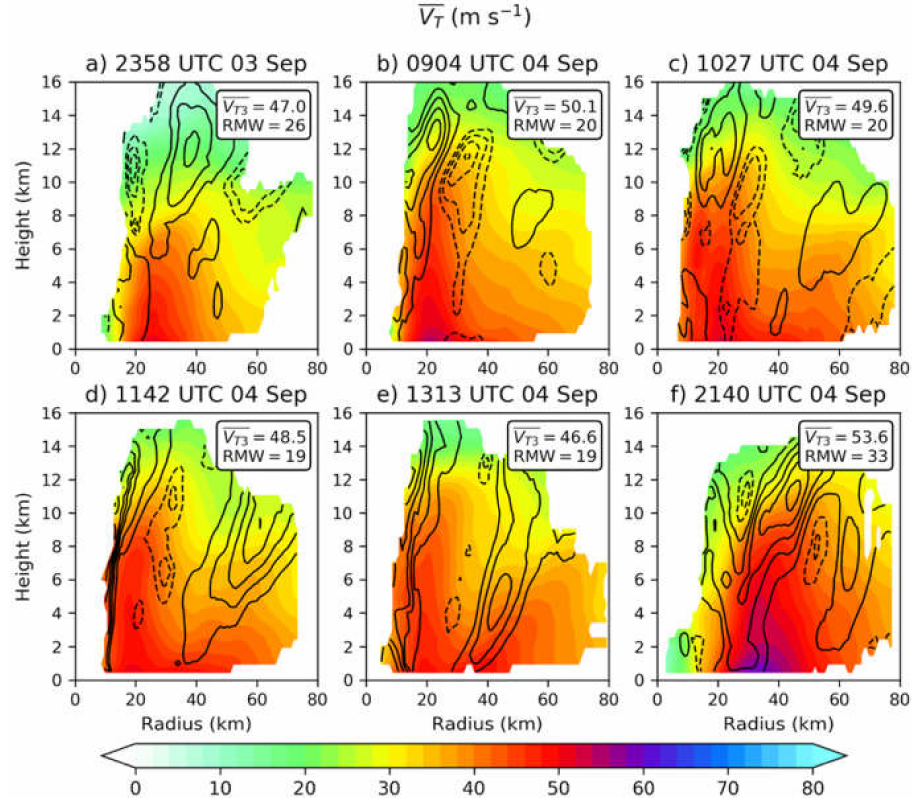
Figure 19. Azimuthally averaged tangential wind (m s − 1 ; shaded) and vertical velocity (contours) obtained from ( a ) the 2358 UTC 3 Sep center pass. Positive vertical velocity values are shown in the solid contours every 0.5 m s − 1 , while negative vertical velocity values are shown in the dashed contours every 0.2 m s − 1 . The inset of the panel depicts the magnitude of the maximum azimuthally averaged tangential wind (V T3 ; m s − 1 ) and RMW (km) at a height of 3 km. ( b ) As in ( a ), but for the 0904 UTC 4 Sep center pass. ( c ) As in ( a ), but for the 1027 UTC 4 Sep center pass. ( d ) As in ( a ), but for the 1142 UTC 4 Sep center pass. ( e ) As in ( a ), but for the 1313 UTC 4 Sep center pass. ( f ) As in ( a ), but for the 2140 UTC 4 Sep center pass. For each flight, only radii withat least 33% azimuthal coverage are shown. Adapted from